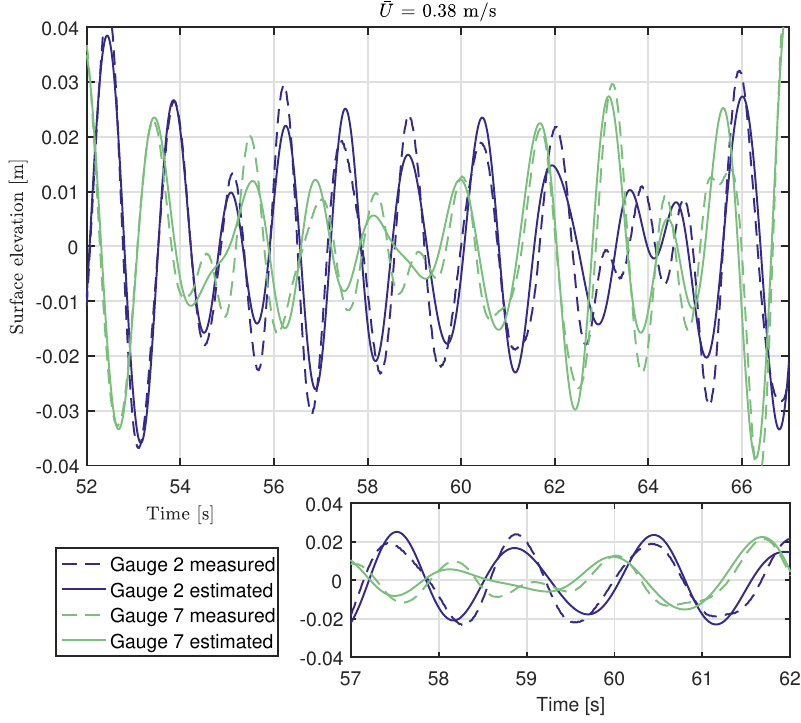
Figure 12. Example of time series simulated from reflection analysis vs. measured over the same time period. Sea State 6 is shown with outputs for Gauges 2 and